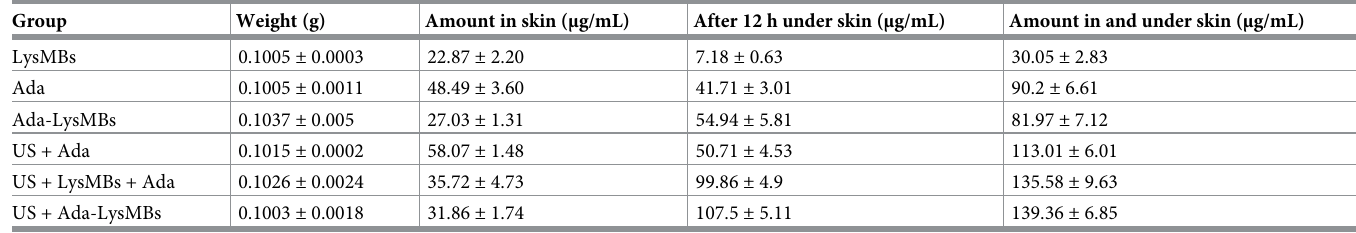
Table 2. Levels of Ada detected in the indicated compartments at 12